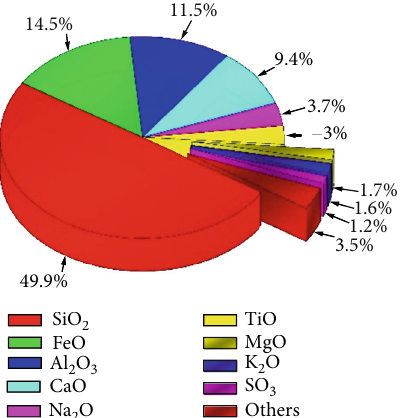
Figure 2: Compressor blade